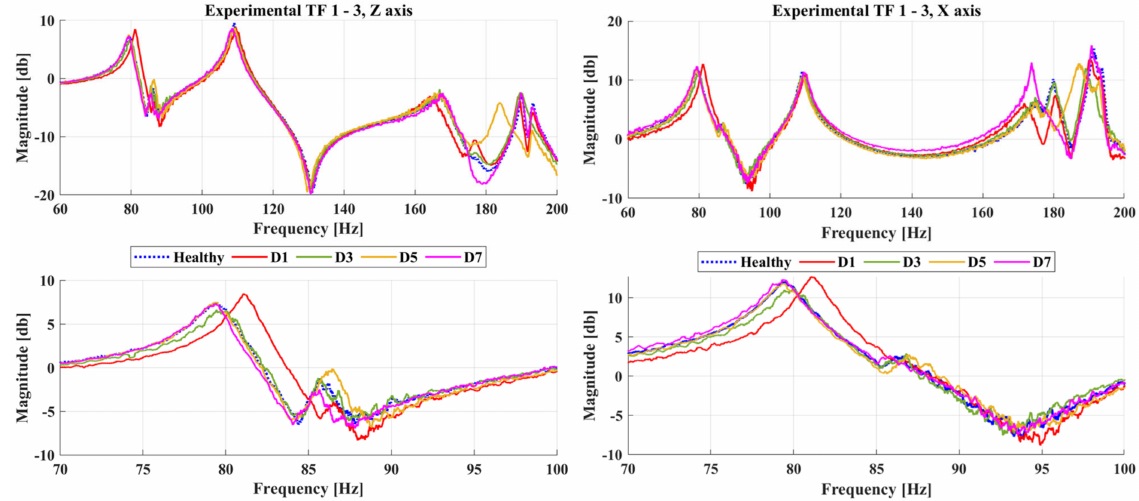
Figure 9. Experimental time response signal of Accelerometer 1 [A1] on X‑axis.